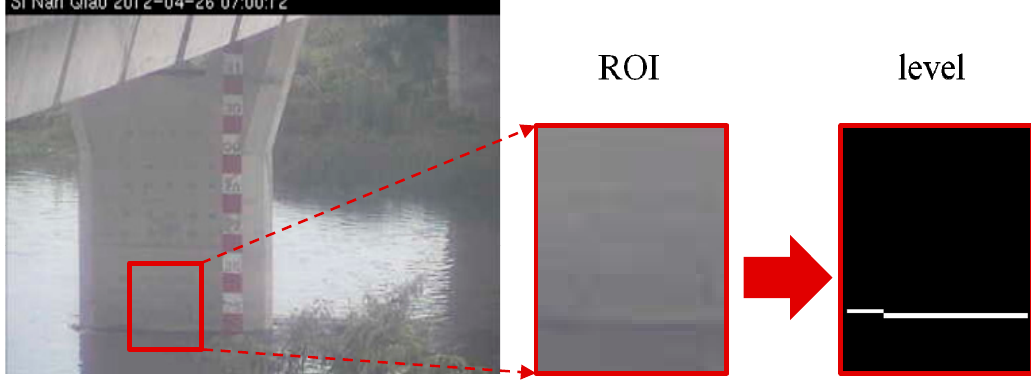
Figure 3. The target object (ROI) plot in the image.